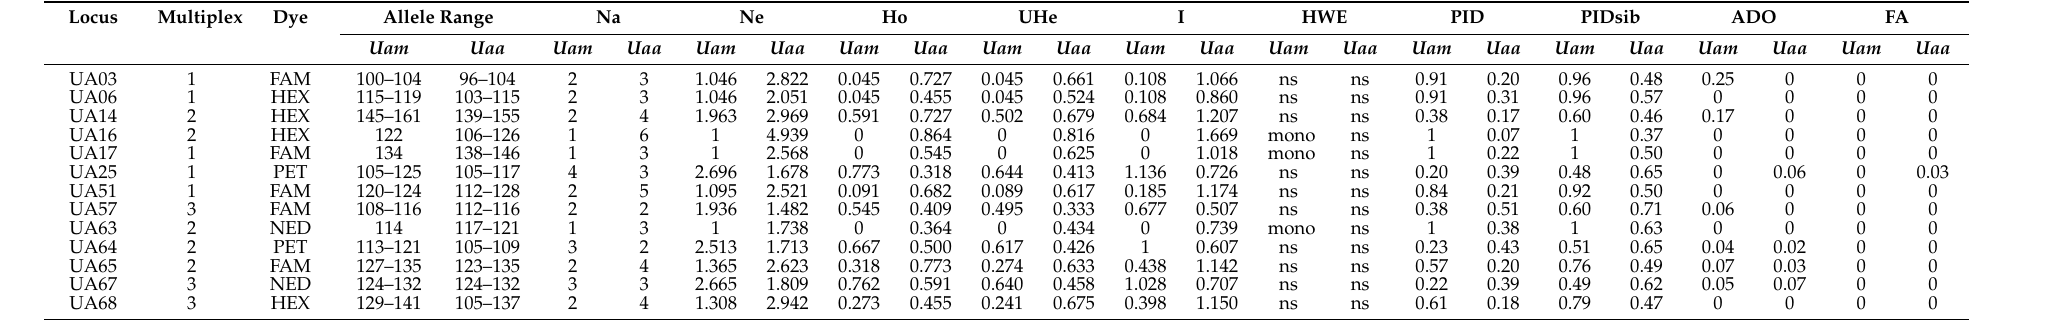
Table 2. Genetic diversity parameters and genotyping errors of 13 STR markers (NEW set) of 44 Italian brown bear U. a. marsicanus ( Uam) and U. a. arctos ( Uaa) genotypes. Number of PCR multiplexes, dye of microsatellite primers, allele range, number of alleles (Na), effective number of alleles (Ne), observed (Ho)